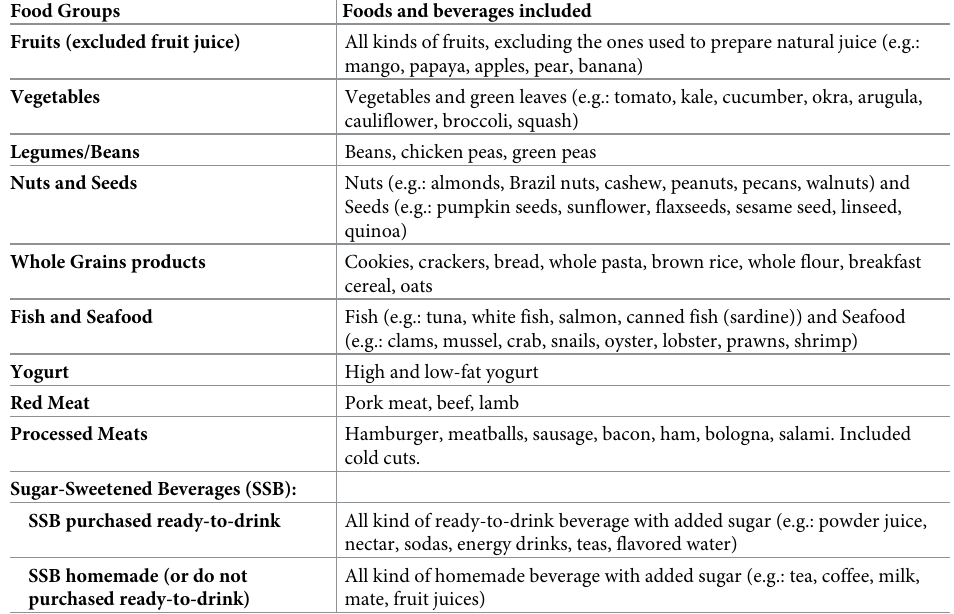
Table 1. Composition of the ten food groups related to